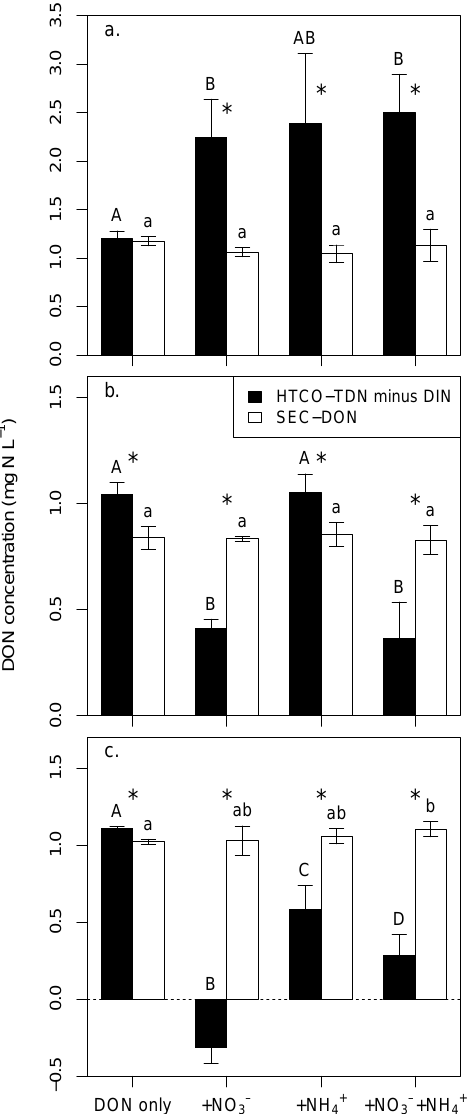
Fig. 4. Mean ( ± 1SD) of DON calculated by the standard ap- proach (HTCO-TDN minus DIN (DIN=(NO − +NO − )+NH + ), 6– 3 2 4 11 measurement replicates) or measured by size-exclusion chro- matography (SEC-DON, 5 measurement replicates) for different natural organic matter treatments (NOM). (a) Fuchskuhle NOM, (b) Schwarzer See NOM, (c) Wetland outflow. NO − and/or NH + 3 4 was added to the samples so that a DIN:TDN ratio of 0.8 was reached. The treatment without added NO − and/or NH + is indi- 3 4 cated as “DON only”, the treatments with additions are indicated as “+NO − ”, “+NH + ” or “+NO − +NH + ”. Means and uncertainties 3 4 3 4 of the standard approach were calculated by MC simulations. Let- ters indicate significant differences between the treatments: capital letters for the standard-approach determinations and small letters for the SEC-DON measurements. Asterisks indicate significant dif- ferences between the results from the standard-approach and SEC- DON determinations (pairwise bootstrap test). Please see Table 1 for further details on the